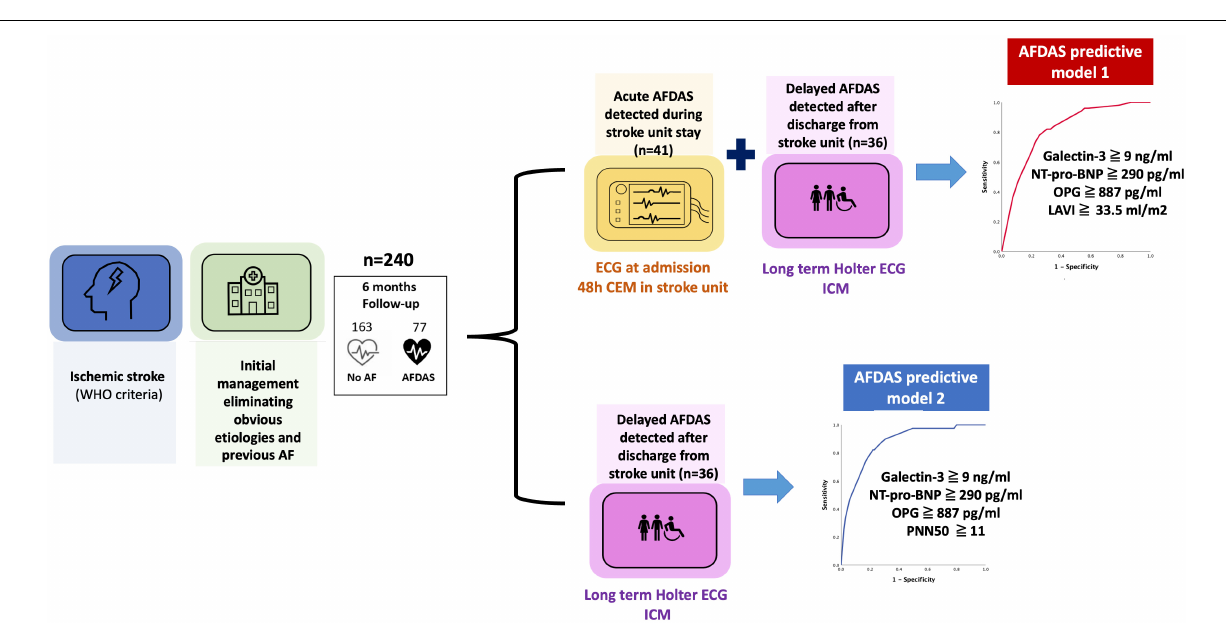
FIGURE 3 | SAFAS study main